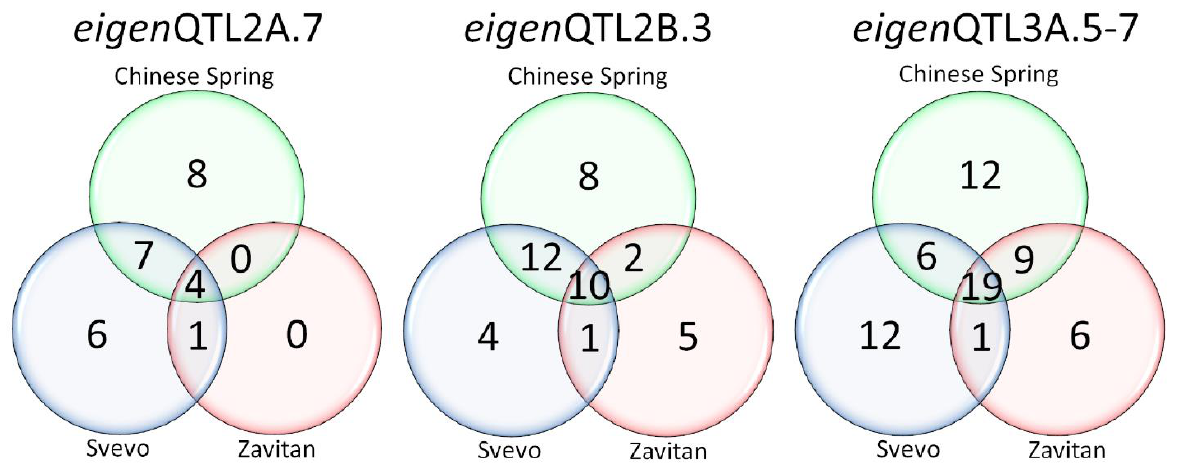
Figure 5. Comparison of unique gene models among the different genomes within the selected QTL hotspots. From 133 gene models within the three QTL hotspots, 33 (25%) were common for the three genomes, 25 (19%) were common between ‘Chinese Spring’ and ‘Svevo’, 11 (8%) were common between ‘Chinese Spring’ and ‘Zavitan’, and 3 (2%) were in common between ‘Svevo’ and ‘Zavitan’. Finally, 46% of the gene models were unique for the different genomes.